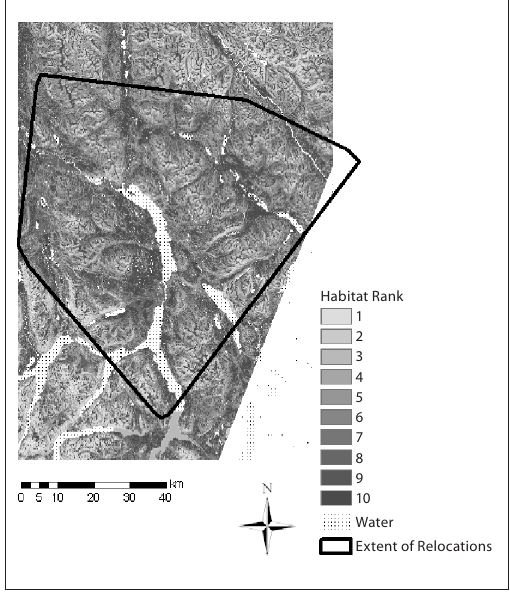
Fig. 4a. Current habitat ranking of caribou winter habitat in the Southern Lakes region of the Yukon Territory, Canada. The solid line is a 100% mini- mum convex polygon of all winter GPS reloca- tions collected during the study.